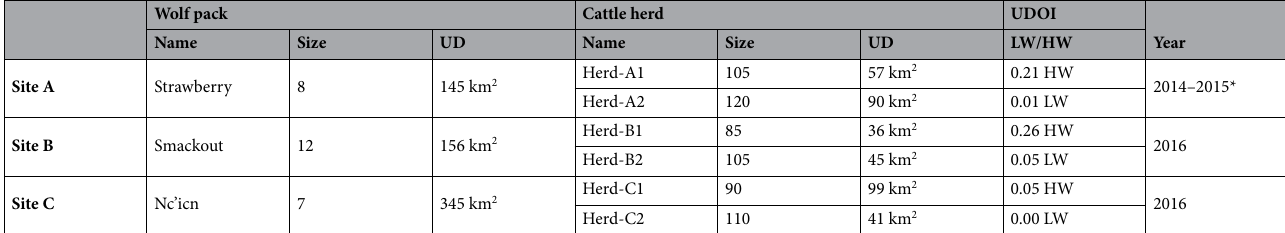
Table 1. Sites with wolf packs, cattle herds, and utilization distribution overlap index (UDOI). Wolf pack size is the minimum number of wolves which included adults, juveniles, and pups of the year, and was determined using remote trail-cameras and direct pup counts from May to October. Cattle herd size was the number of cow-calf pairs. Utilization distributions (UD) were estimated by a 95% kernel density estimator using GPS points collected between May and October (see Supplementary Information). UDOI, which is based on the product of two utilization distributions (95% volume contour) (see Supplementary Information), represented an index of spatial interaction between wolves and cattle; within each site lower values of UDOI indicate herds in lower wolf-impacted area (LW), and higher values of UDOI indicate herds in higher wolf-impacted area (HW). *Data for site A were combined and averaged for the years 2014 and